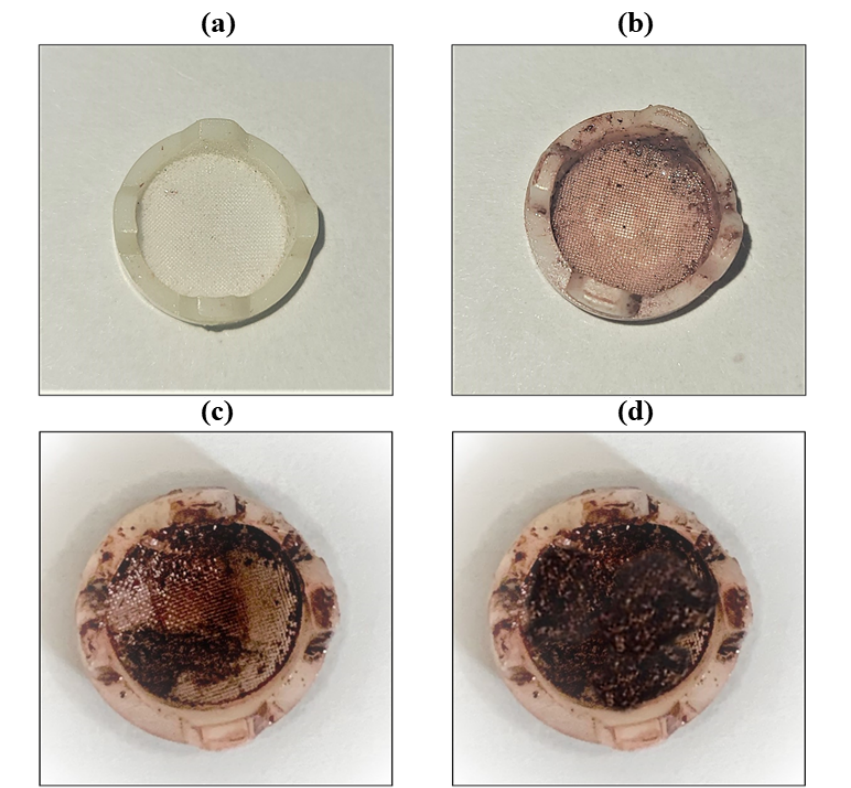
Figure 4. Pictures showing the suction filter at different stages ( a ) before the experiment, ( b ) nor- mal running condition, ( c ) partial clogging leading to cavitation, and ( d ) clogged filter at end of